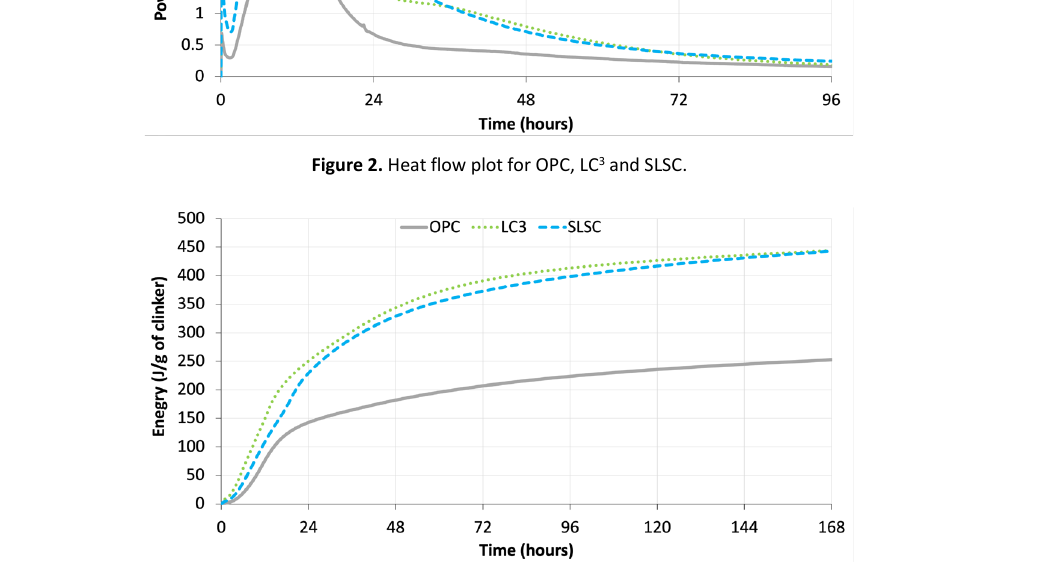
Figure 3. Cement mortar compressive strength plot for OPC, LC 3 and SLSC.